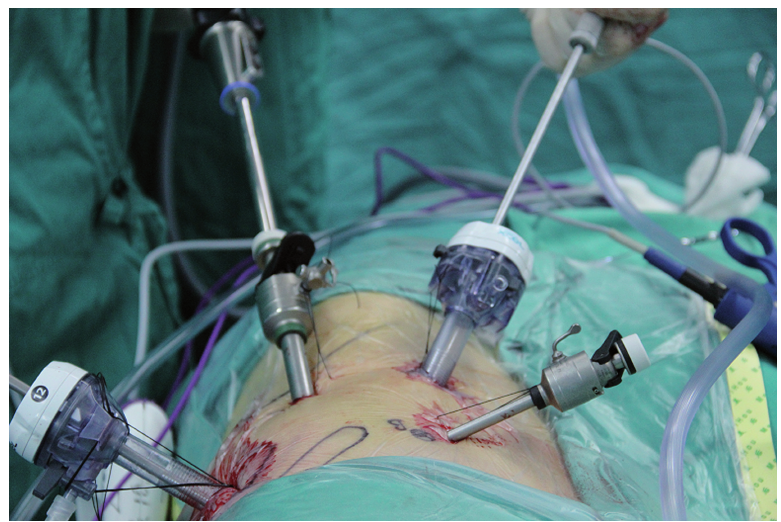
Figure 1 - Positions of the four working trocars.